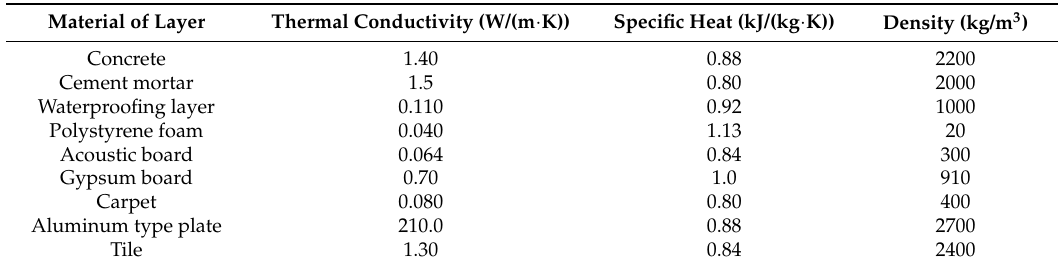
Table 2. Thermal property of each wall layer.